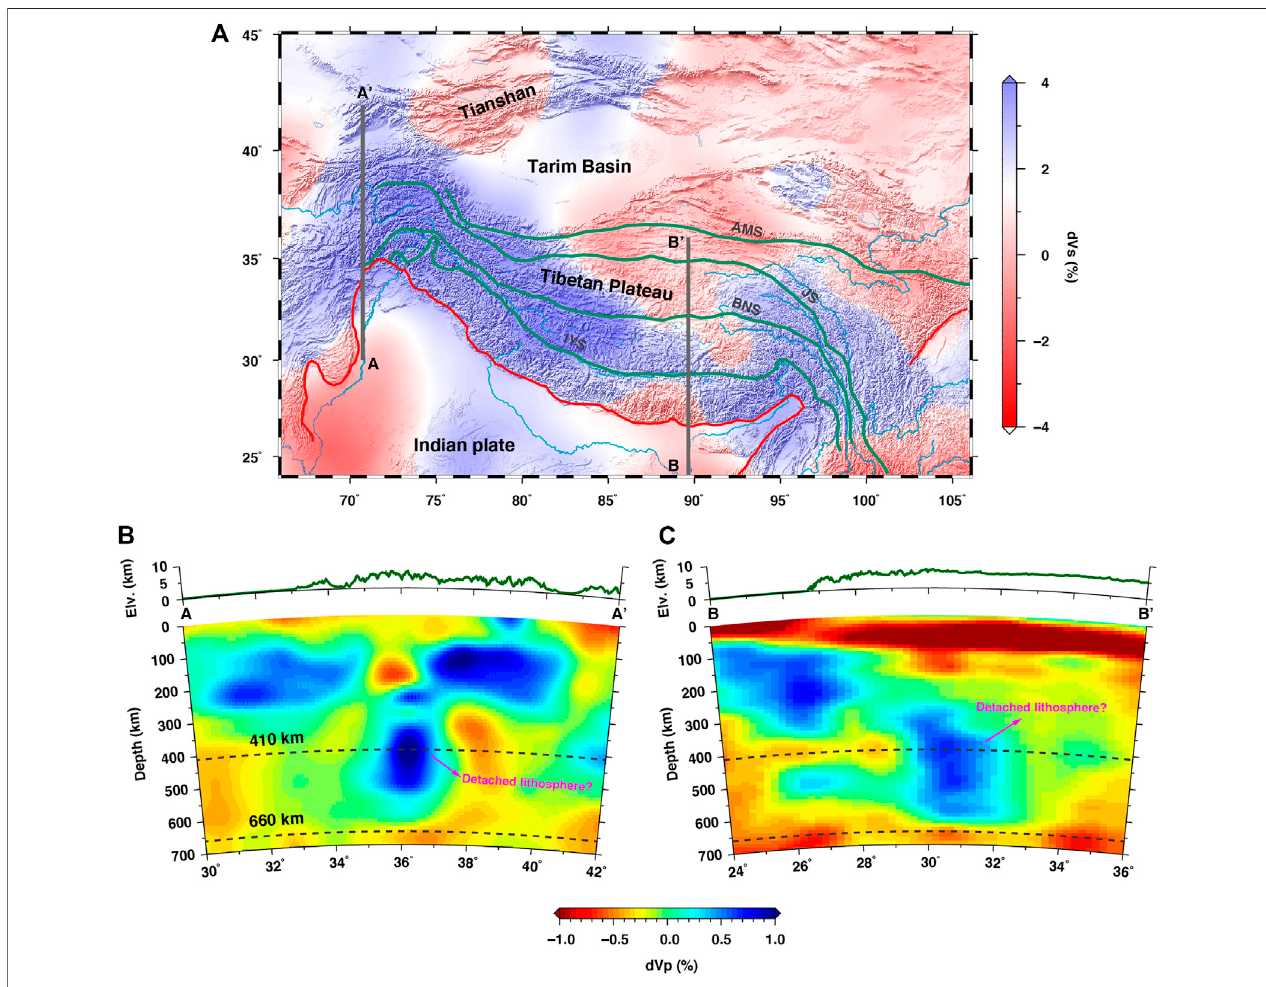
FIGURE10|(A) AverageS-wavevelocityanomaliesbetween75and375 kmdepthintheTibetanplateau.ThedataarefromSchaefferandLebedev(2013). (B,C) P-wave velocity variations at two cross sections, showing subvertical high-velocity structures in the upper mantle. The locations of the cross sections are shown in (A) . The data are from Li et al. (2008). Dark green curves indicate suture zones within the Tibetan plateau (Taylor and Yin, 2009). See Figure 1 for abbreviations.